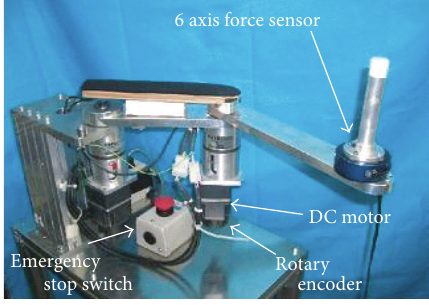
Figure 1: 2-link arm.